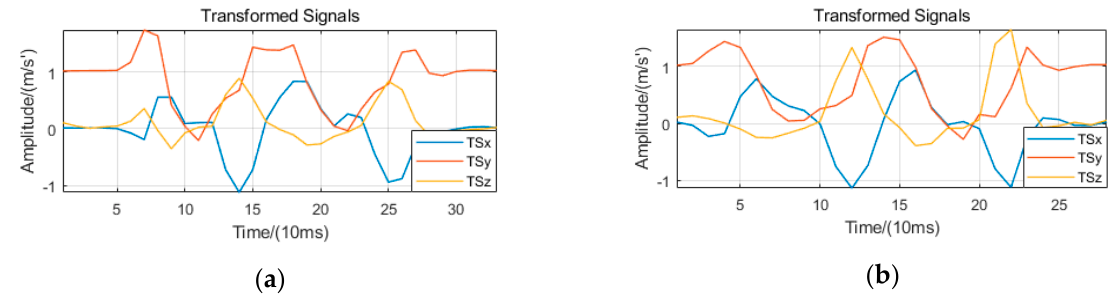
Figure 8. ACC curves after coordinate conversion. ( a ) Curves of VWM and ( b ) curves of fVWM.